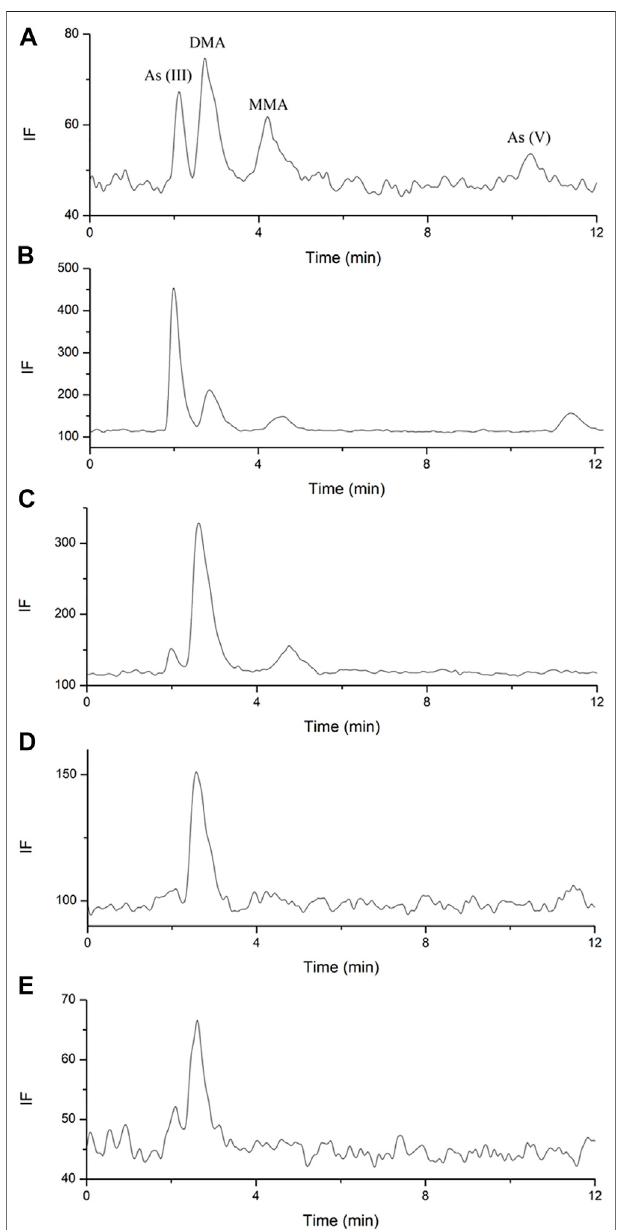
FIGURE 4 | Representative arsenics urine species chromatograms. (A) . blank spikedwitharsenicspecieseach of3.125 ng; (B) .sampleof4 – 8 hafter singledose; (C) .sampleof48 haftersingledose; (D) .sampleof10 daysafter single dose; (E) . sample of 38 days after multiple doses.